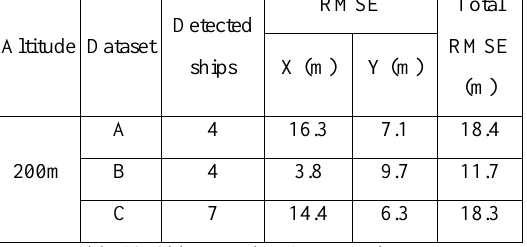
Figure 10. BBox-Label-Tool